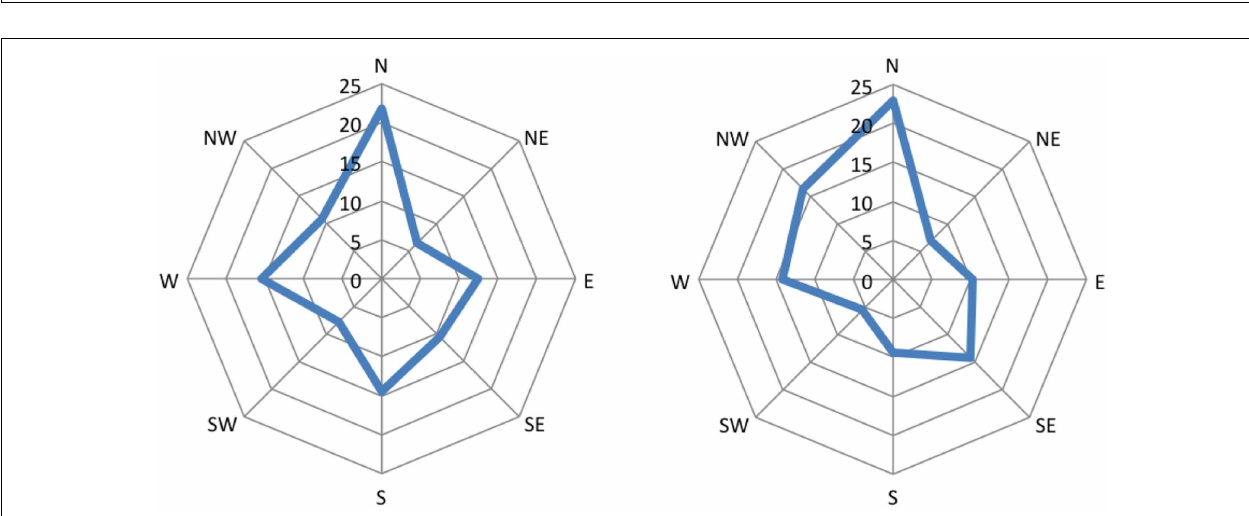
FIGURE 5 | Distribution of eye movements during first premises of the form “A is north-west of B.” Amplitude represents the percentage of saccades mapped onto the respective cardinal